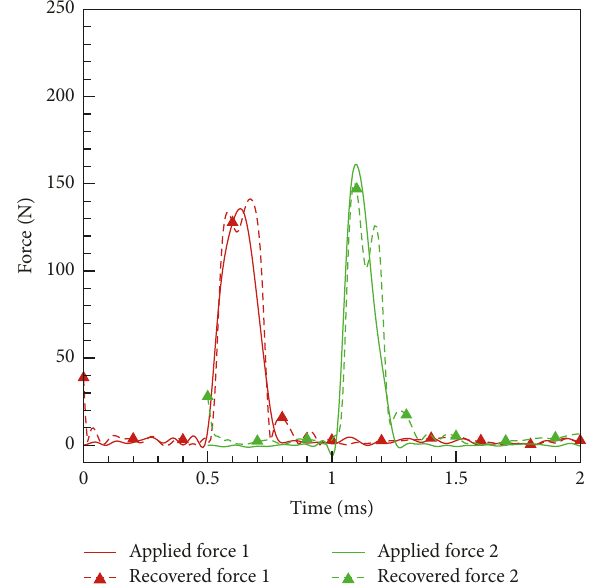
Figure 9: Applied and recovered force signals of two calibration